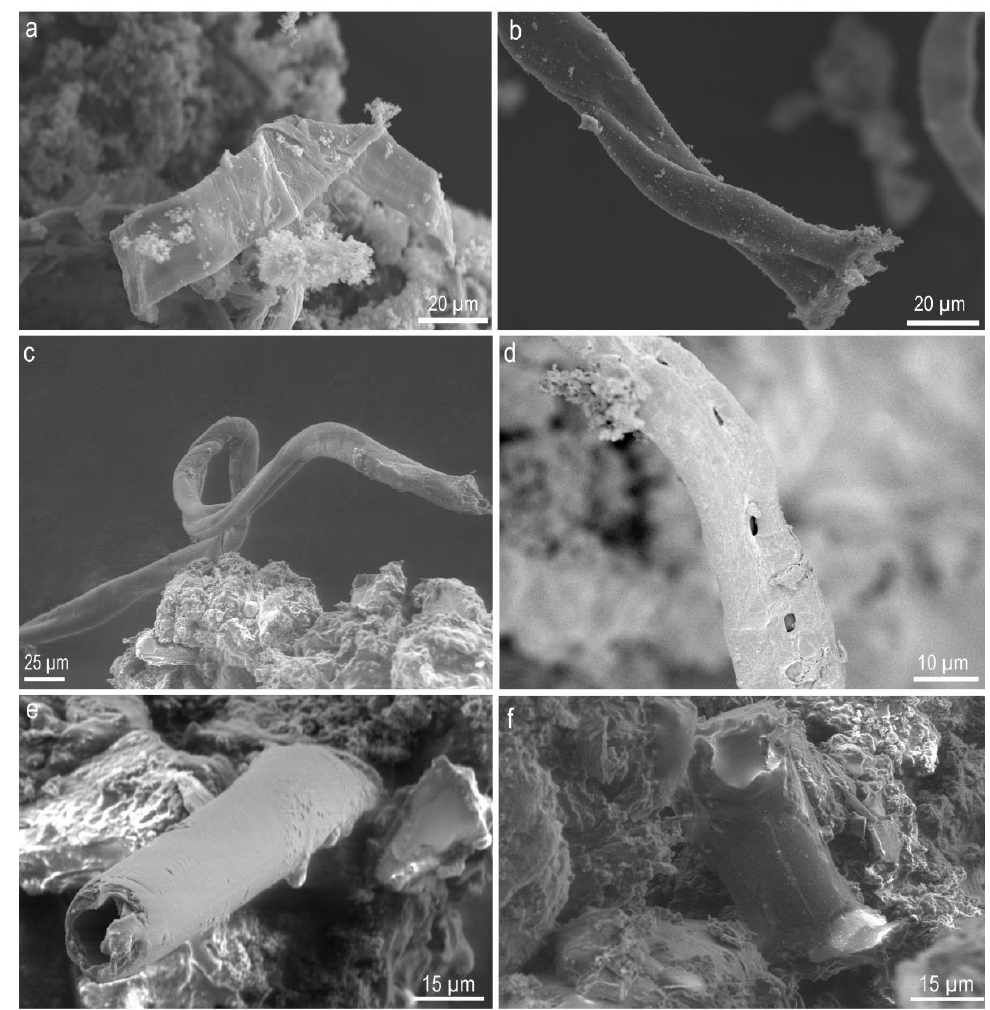
Figure 4. SEM images of the residue obtained after shock processing of 18 amino acids (Table S1). Several features, including ( a ) a thin ribbon, ( b ) a typical helical structure, ( c ) a branching filamentous thread and ( d – f ) a hollow tubule, were observed.